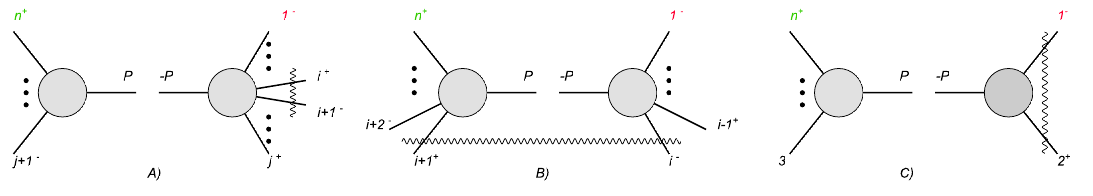
Figure 4 . The action of the gluing operators ˆ A ii +1 on the individual BCFW terms of the on- shell [1 − , n + recurcion in general case. A ) diagrams will give A type terms of the off-shell BCFW i recurcion, B ) type diagrams will give B type terms, while C ) diagrams will give C and D type terms of the off-shell BCFW